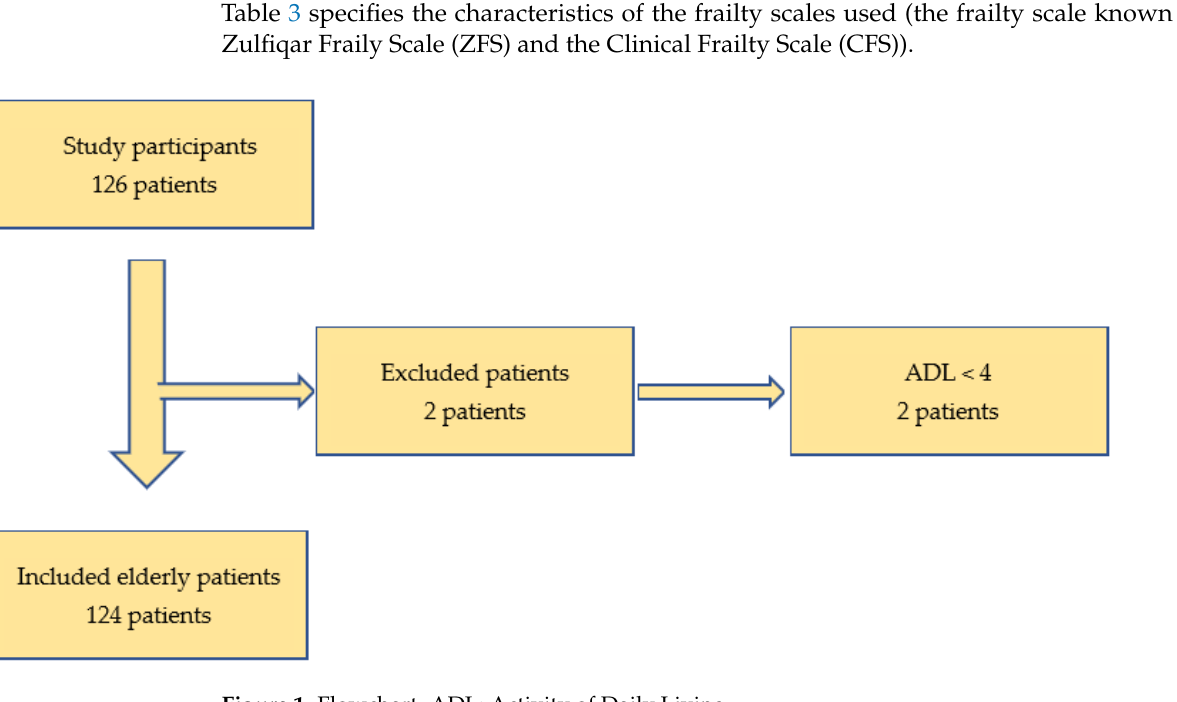
Figure 1. Flowchart. ADL: Activity of Daily Living. Table 2. Description of the sample.